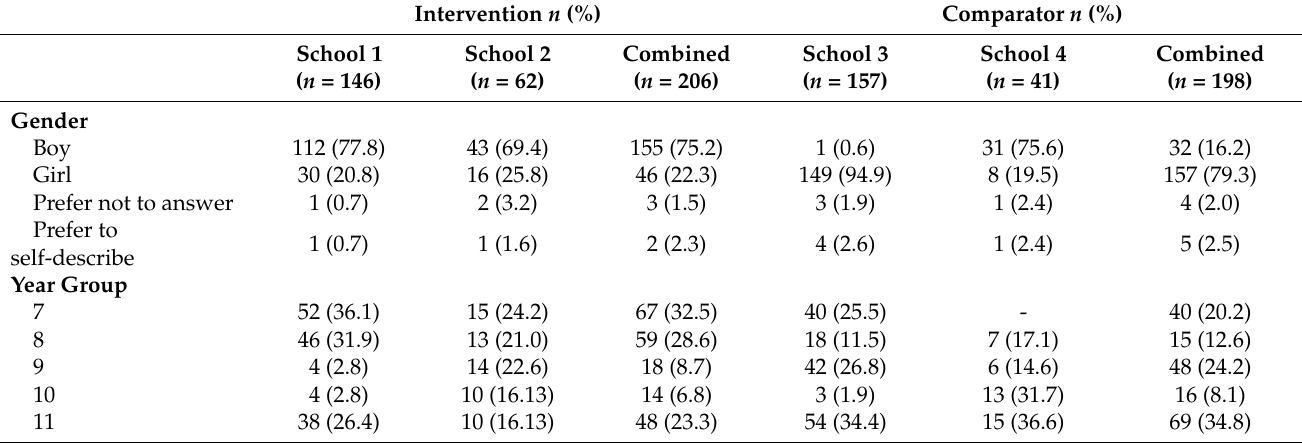
Table 3. Characteristics of survey participants ( n =